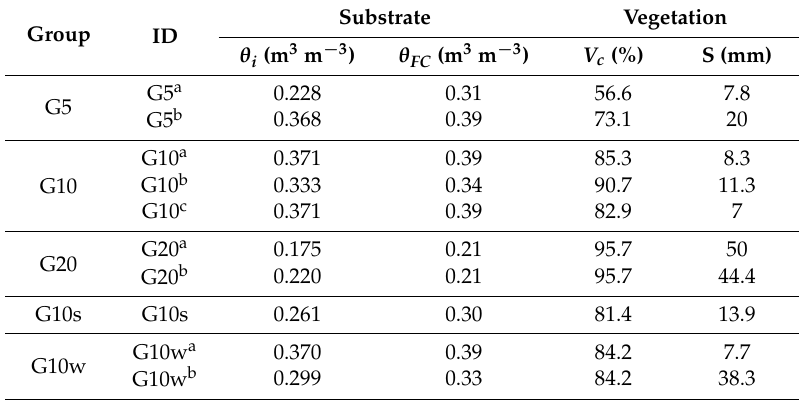
Table 3. Evaluated parameters for each specimen: θ i is the initial substrate moisture, θ FC is the field capacity, V c is the vegetation coverage and S is the maximum interception capacity.